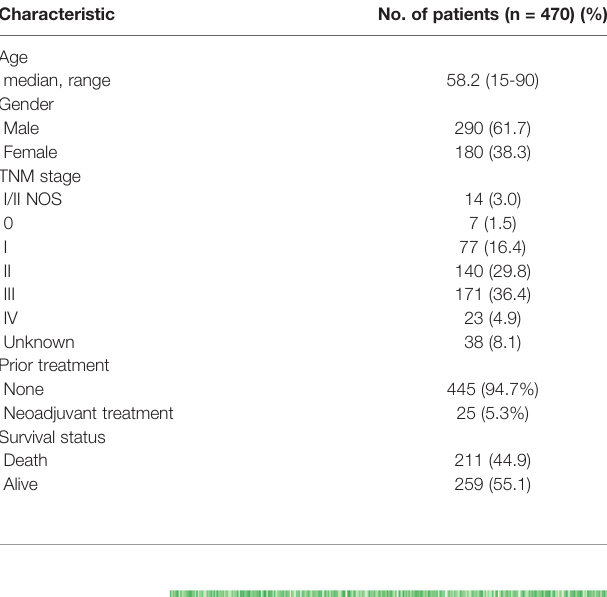
TABLE 1 | Clinical characteristics of the